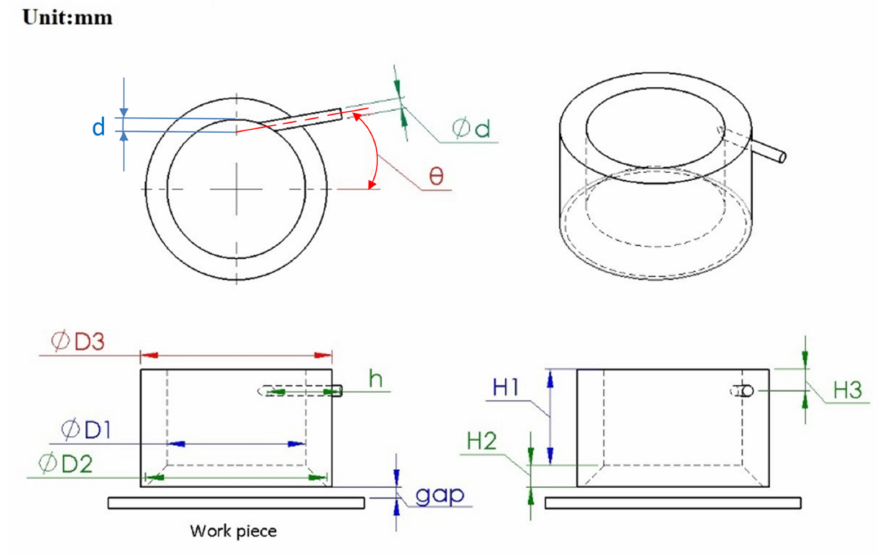
Figure 2. Structure of vortex